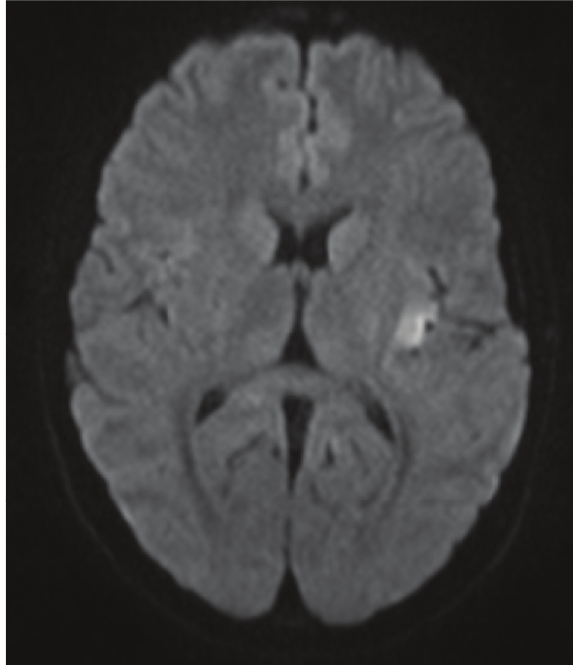
Figure 2: MRI brain: area of diffusion restriction in the left insula.